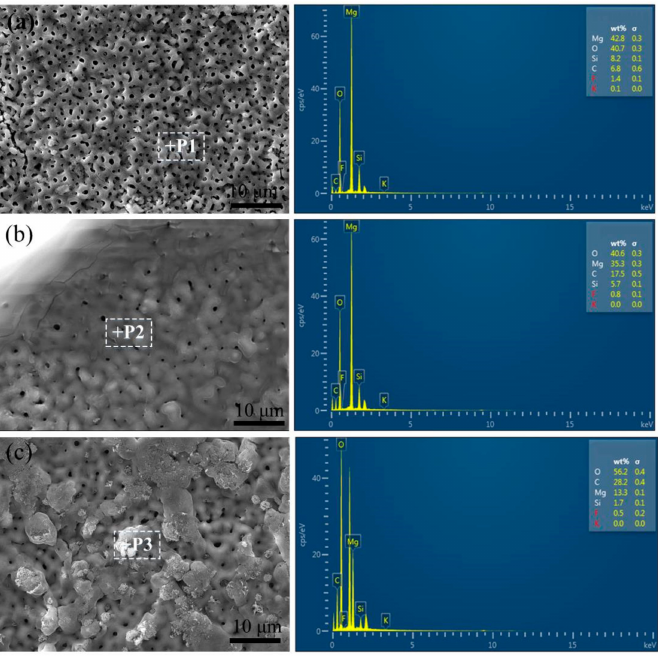
Figure 3. Scanning electron microscopy (SEM) images of the different coatings: ( a ) UMAO, ( b ) UMAO/PLGA, and ( c )